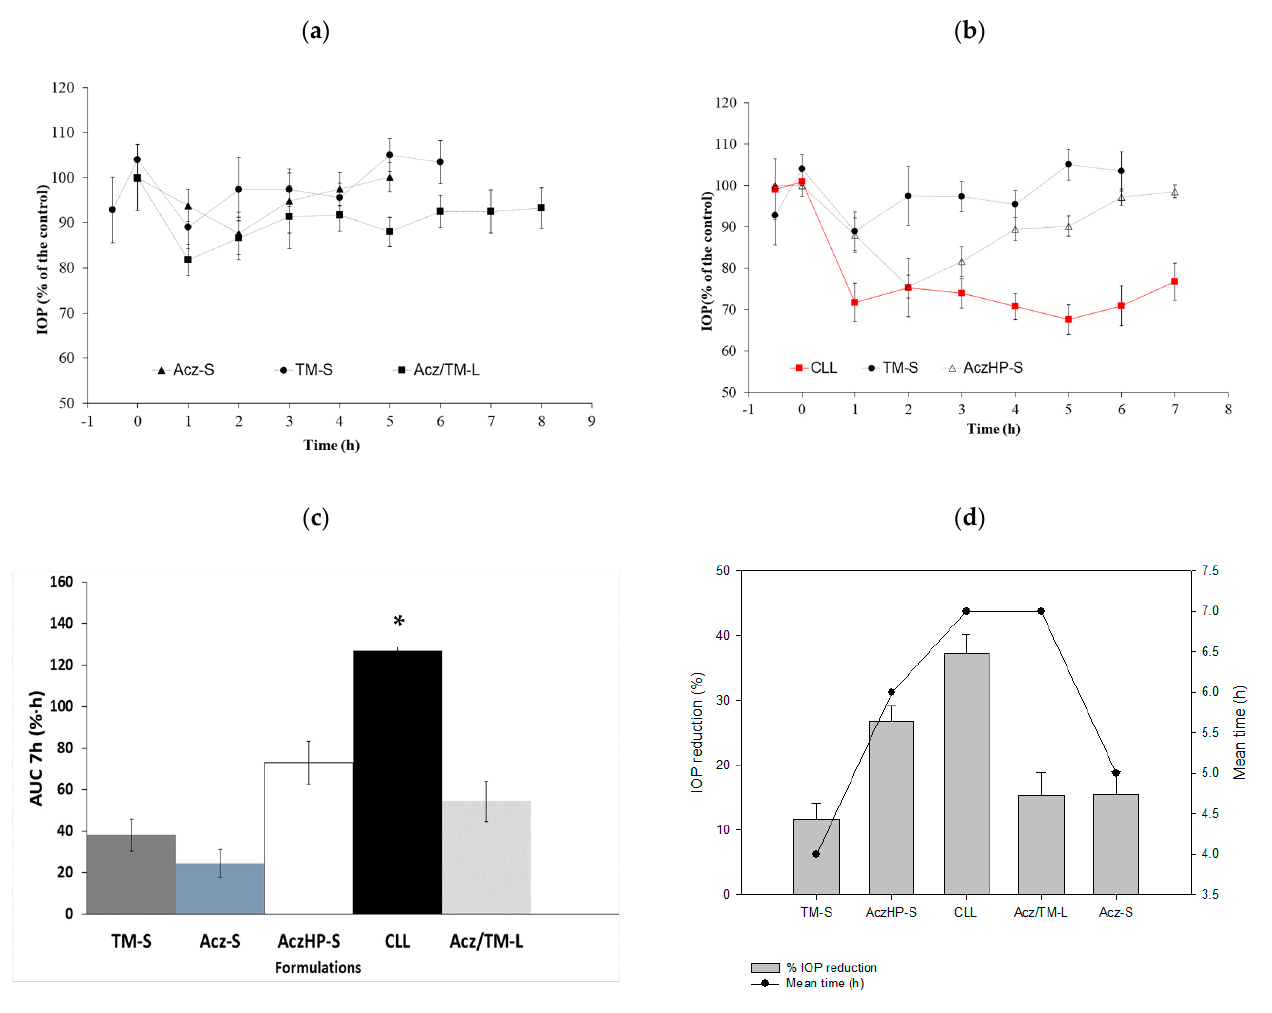
Figure 8. IOP profiles of ( a ): ( (cid:78) ) Acz-S; ( • ) TM-S; ( (cid:4) ) Acz/TM-L; ( b ) ( ∆ ) AczHP-S; ( • ) TM-S; ( (cid:4) ) CLL. ( c ) Area under the curve (AUC07h (% · h) ± SD) for each formulation. * Significant differences with Acz/TM-L, Acz-S, AczHP-S, and TM-S ( p -value < 0.05). ( d ) Maximal IOP reduction (%SEM) and the mean time effect (h) of Acz and TM for each